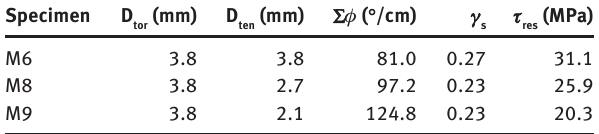
vs. applied shear N